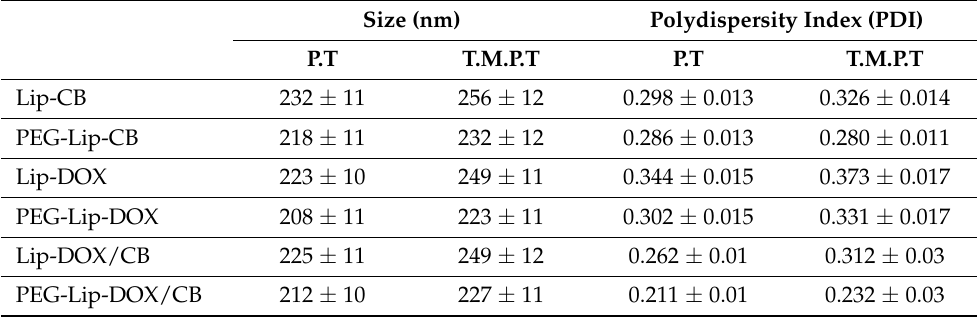
Figure 4. ( A ) Cumulative drug release from Lip-DOX, Lip-CB, Lip-DOX/CB, PEG-Lip-DOX, PEG- Lip-CB, and PEG-Lip-DOX/CB and ( B ) cell viability effects of Lip-DOX, Lip-CB, Lip-DOX/CB, PEG-Lip-DOX, PEG-Lip-CB, and PEG-Lip-DOX/CB three months after preparation. The data are expressed as mean ± SD ( n = 3). Table 5. Size and polydispersity index (PDI) for Lip-DOX, Lip-CB, Lip-DOX/CB, PEG-Lip-DOX, PEG-Lip-CB, and PEG-Lip-DOX/CB on the production time (P.T) and three months after prepara- tion (T.M.P.T).